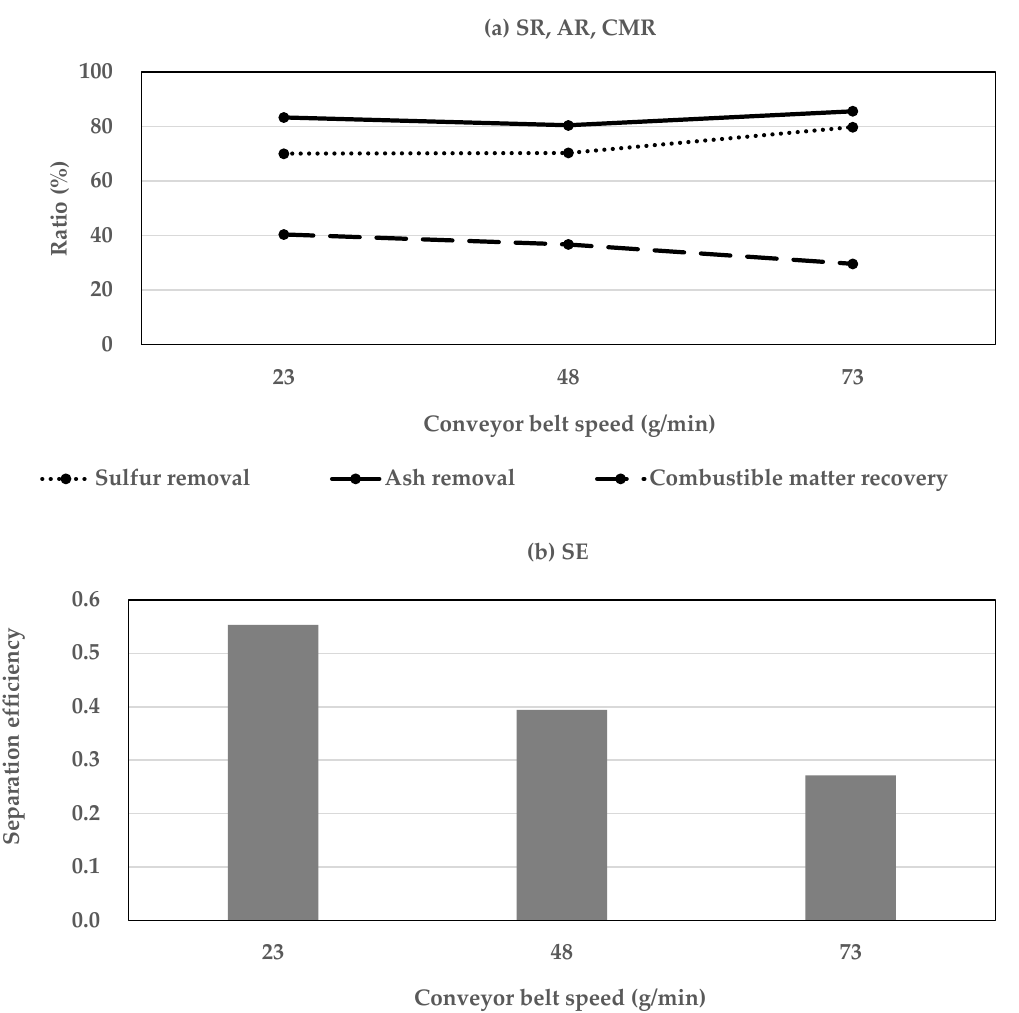
Figure 8. Performance of the separator at different conveyor speeds: ( a ) ash removal ratios (%), sulfur removal ratios (%), and combustible matter recovery ratios (%); ( b ) efficiencies of coal separation using a dry coal cleaning system with two-stage corona electrostatic processes.